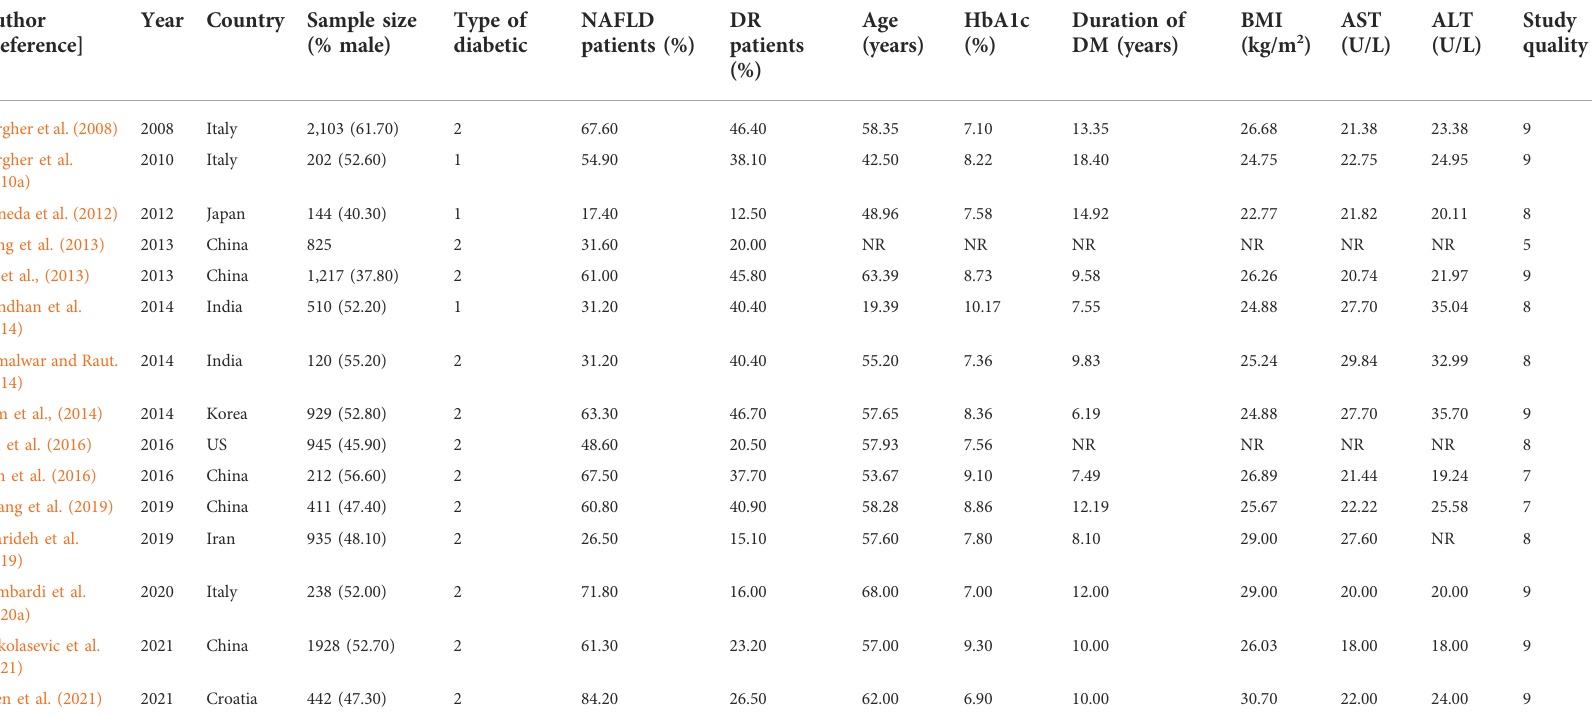
TABLE 1 Basic characteristics of the studies included in the review of association between non-alcoholic fatty liver disease and the risk of diabetic retinopathy in diabetes